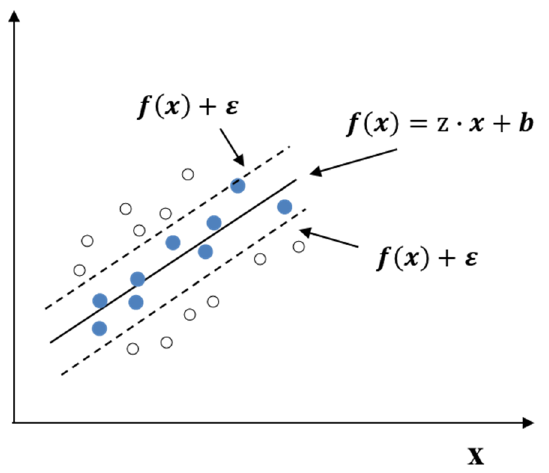
Figure 5. Basic principle of SVR.